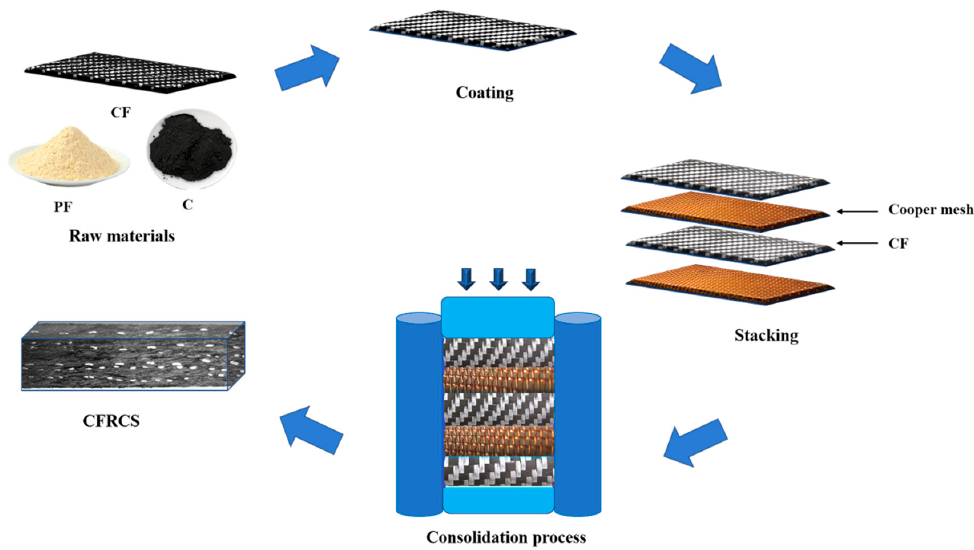
Figure 1. Schematic diagram of pantograph slide plate preparation. Table 2. The ratio of raw materials.